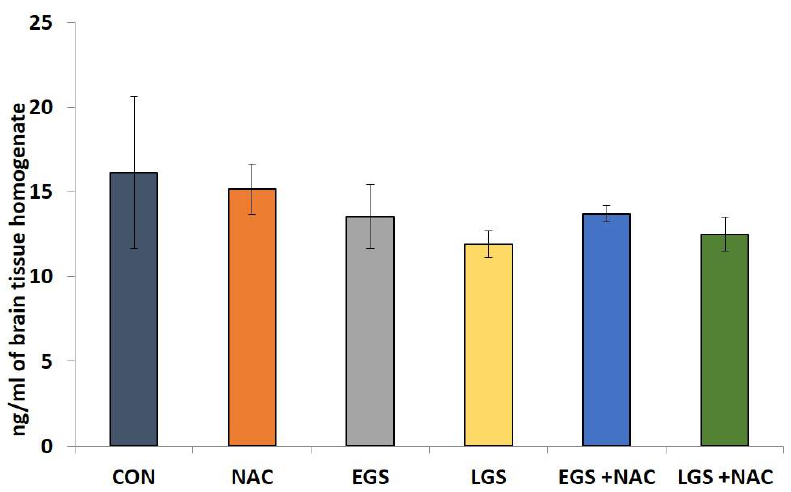
Figure 3. Effect of prenatal stress and NAC on whole brain homogenate norepinephrine levels (nmol/ml) at PND 36 in rat offspring. One-way ANOVA, Tukey-Kramer Multiple Comparisons Test, each bar represents mean ± SEM, n = 12. Data are expressed as mean ± SEM.